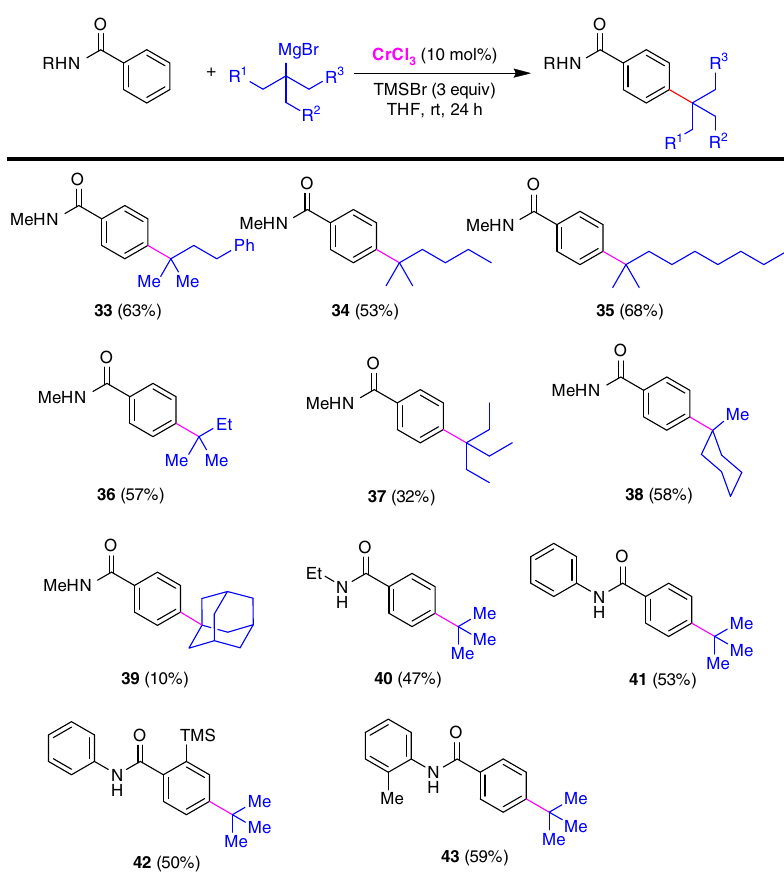
Fig. 3 Cr-catalyzed para -alkylation of benzamides with tertiary alkylmagnesium bromides. Conditions: benzamide (0.2 mmol), tertiary alkylmagnesium bromide (0.8 mmol), CrCl 3 (0.02 mmol), TMSBr (0.6 mmol), THF (0.5 mL), rt, 24 h. Isolated yields are given